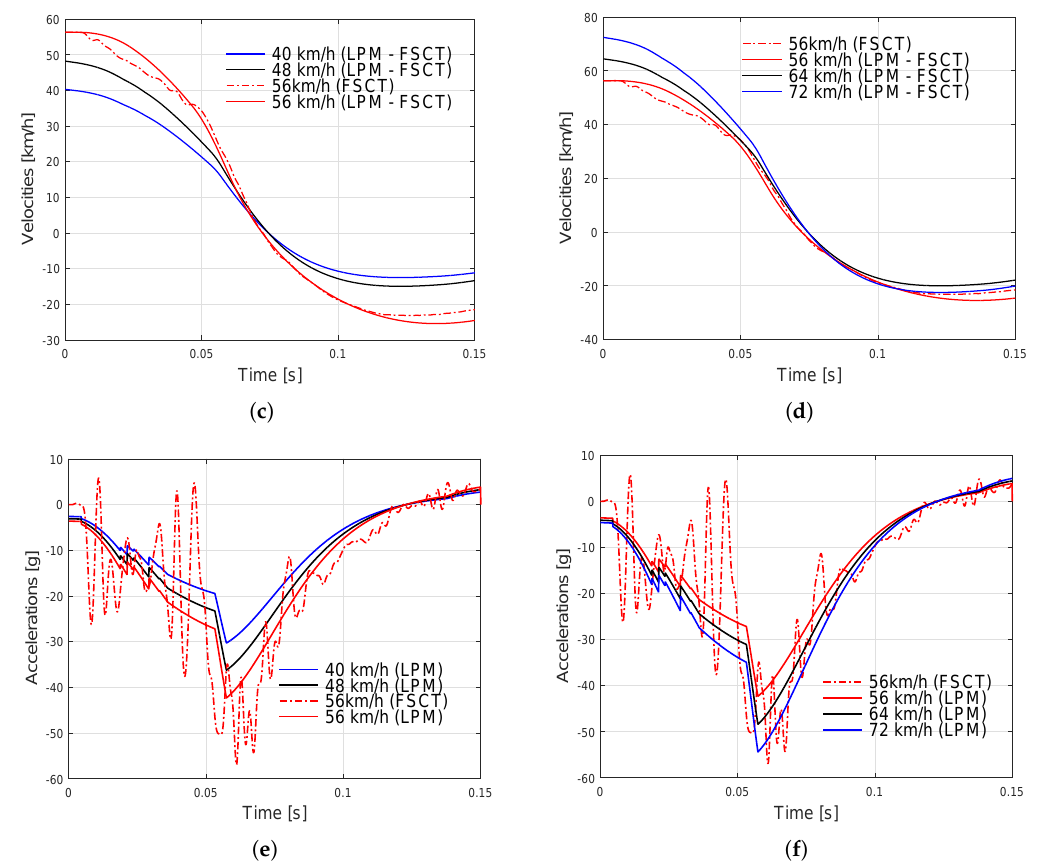
Figure 7. Displacement, velocity, and acceleration plots comparison in case of LPM calibrated to FSCT, ( a , c , e ) impact velocities lower than the calibration point (56 km/h); ( b , d , f ) impact velocities higher than the calibration point.